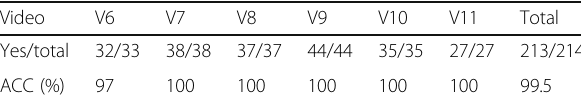
Table 4 Test result that whether the basketball video score is a